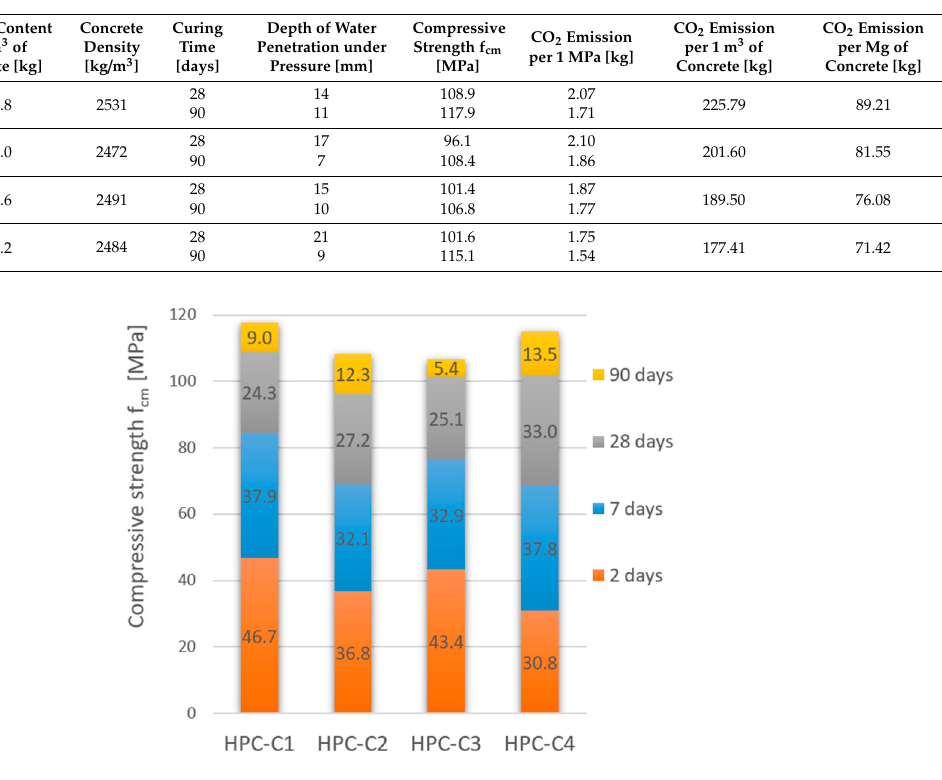
Table 13. Properties of HPC with CO 2 emission level.